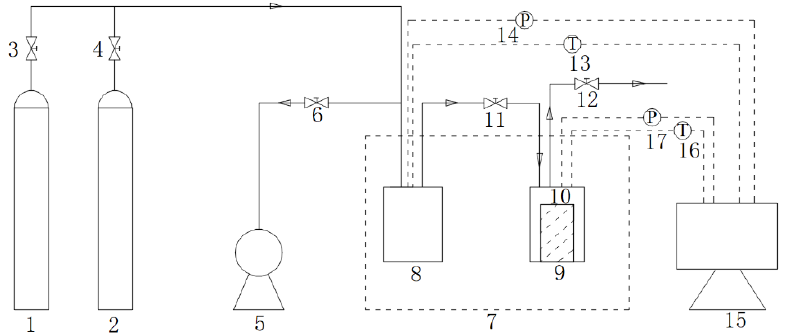
Figure 1. Experimental apparatus for replacing CH 4 from hydrate using CO 2 . 1: methane cylinder; 2: carbon dioxide; 3, 4, 6, 11, and 12: valve; 5: vacuum pump; 7: water bath; 8: buffer tank; 9: reactor;